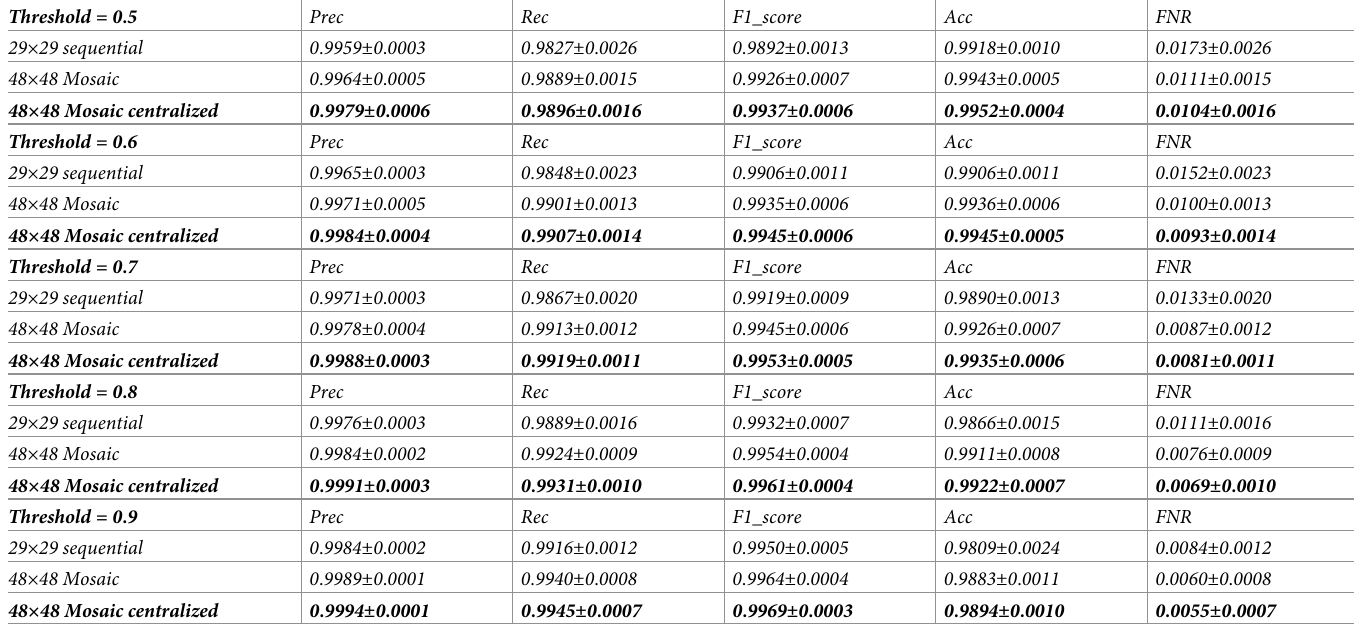
Table 2. 29-bit CAN ID test results for all four